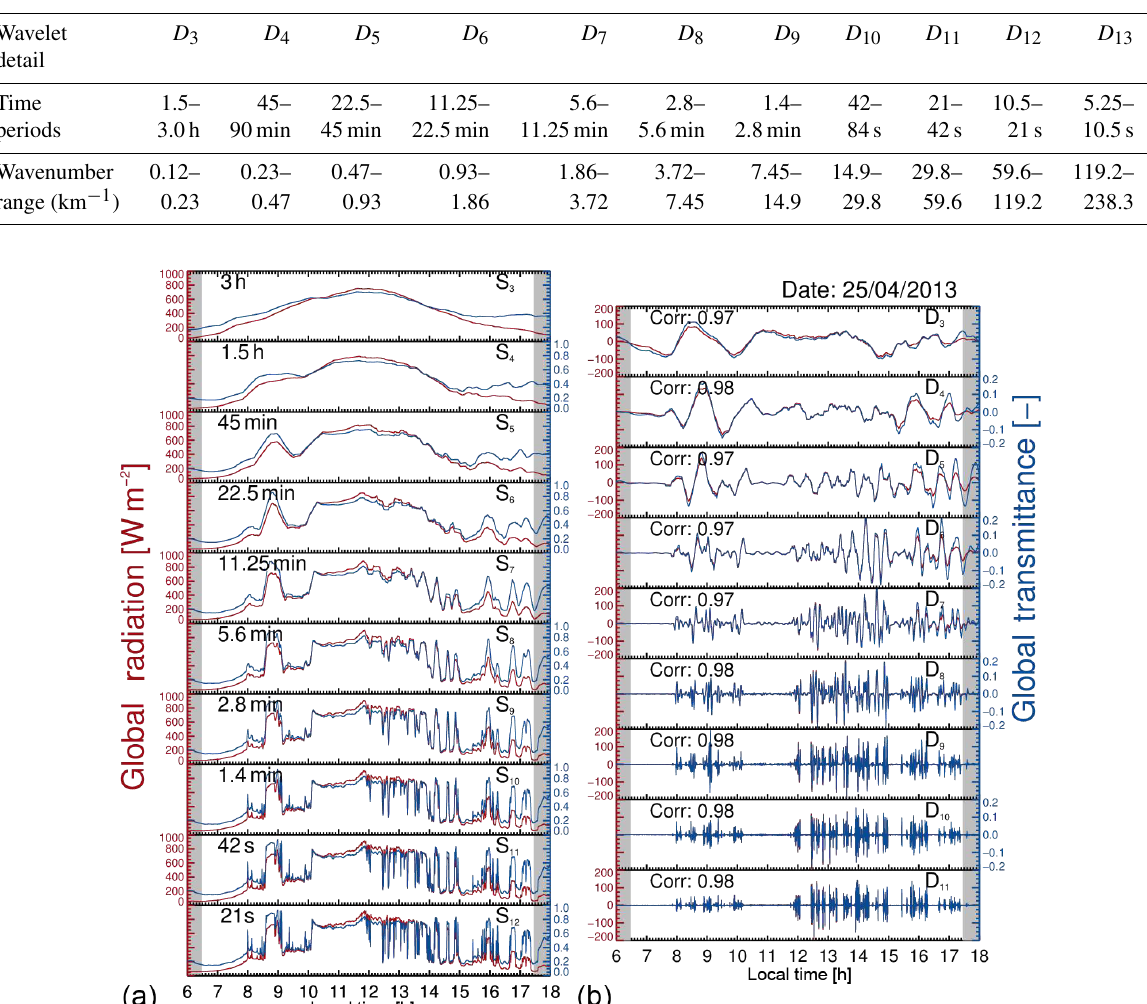
Table 2. Averaging time periods and wavenumber range corresponding to each wavelet detail ( D J ).